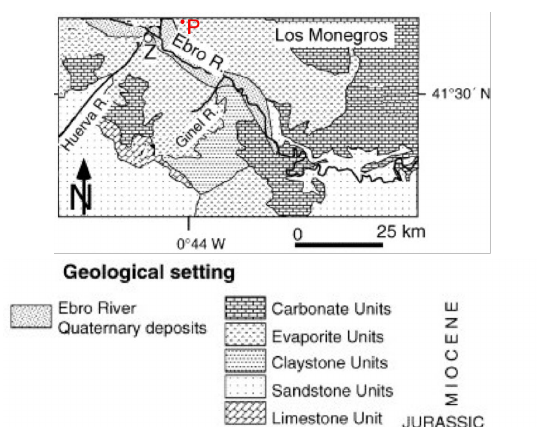
Figure 6. Geological location of Perdiguera (P) and Zaragoza (Z). Adapted of Valero et al.